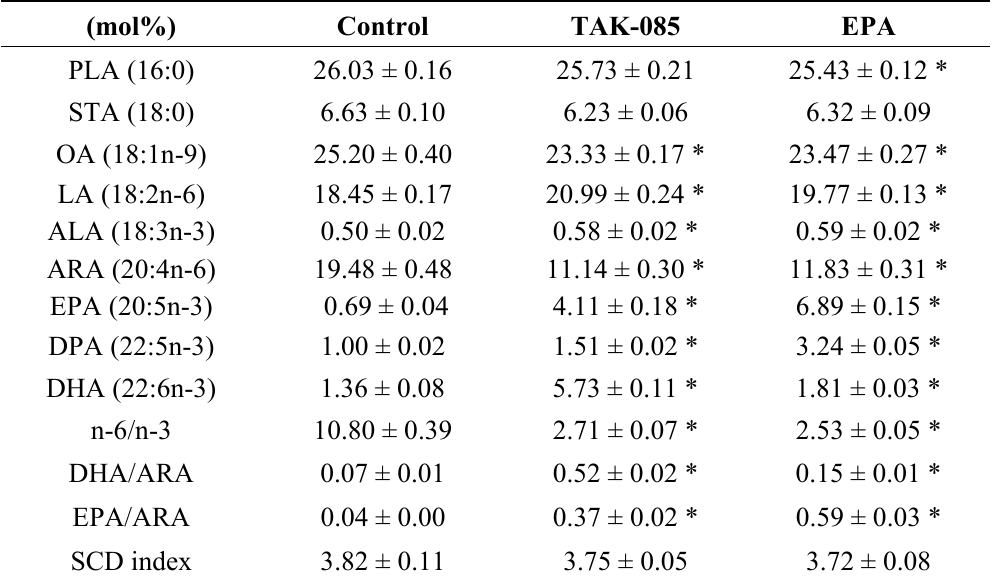
Table 3. Effects of TAK-085 and EPA on fatty acid profiles in plasma.